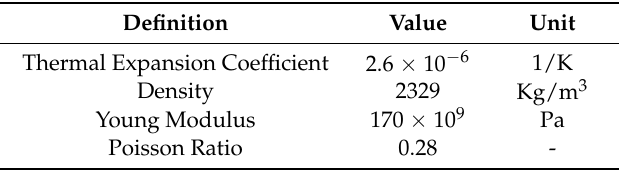
Table 2. The material properties of the silicon.